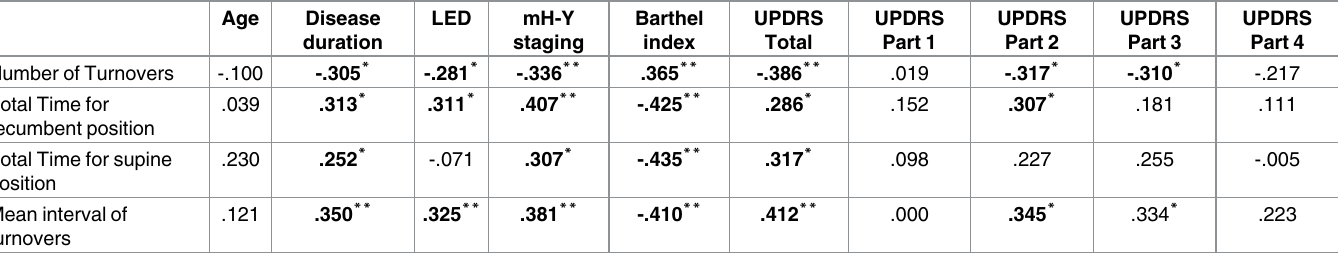
Table 2. Correlation coefficients between nocturnal parameters and patient’s characteristics.